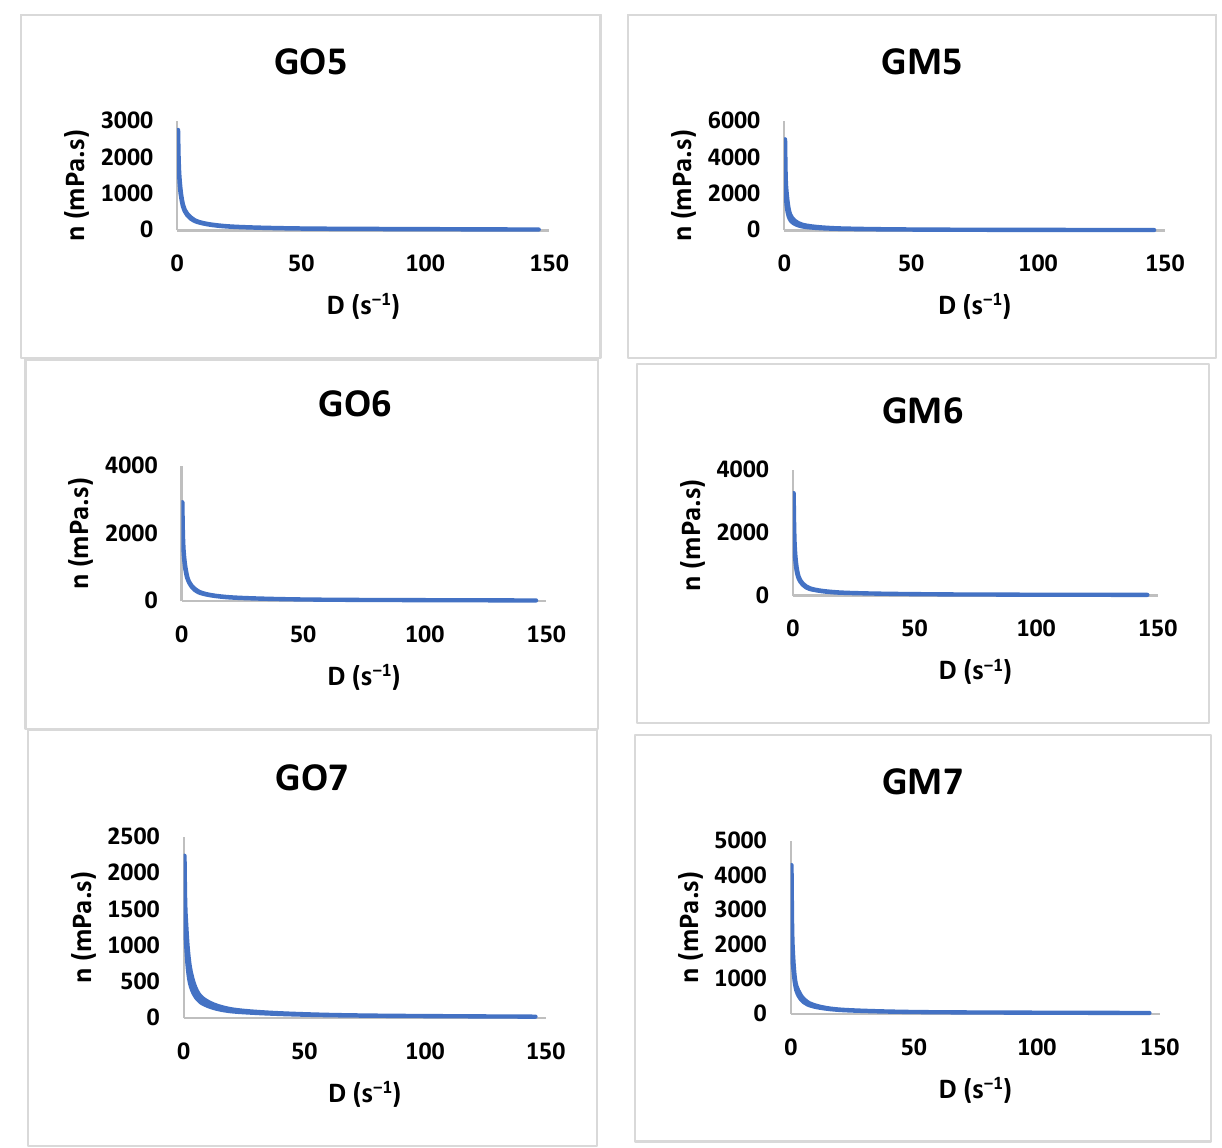
Figure 6. The viscosity profiles for GO1-GO7 and GM1 and GM7. The tangential stress at the first level is influenced positively by X1, X3, and the interaction between X1 × X3, increasing the values of the tangential stress. In the case of Y4 (Figure 3, Table S1 and Equation (S4)), it can be noticed that X1, X2, X3, and the interaction X1 × X3 produce higher tangential stress. In the case of the latter, the influence is lower compared with the first three parameters. The interaction between X1 × X2 conducts to lower tangential stress. The interaction between X1 × X2 shows the same behavior in the case of Y5 (Figure 3, Table S1 and Equation (S5)) and Y6 (Figure 3, Table S1 and Equation (S6)) (decreases tangential stress). The dependent parameters X1, X2, and X3 conduct to an increased value regarding the tangential stress, whilst in the case of Y5, the interaction of X1 × X3 exhibits the same behavior. The viscosity at different levels is influenced by the following dependent parameters: X1, X3, and X1 × X3, all three of them increasing the viscosity for the independent parameters Y7–Y9 (Figure 3, Table S1, Equations (S7)–(S9)). The Y8–Y10 (Figure 3, Table S1 and Equations (S8)–(S10)) parameters are also influenced by the X2 (increased viscosity) and the interaction between X1 × X2 that decreases the viscosity. It can be noticed that the interaction between X1 × X2 decreases both the tangential